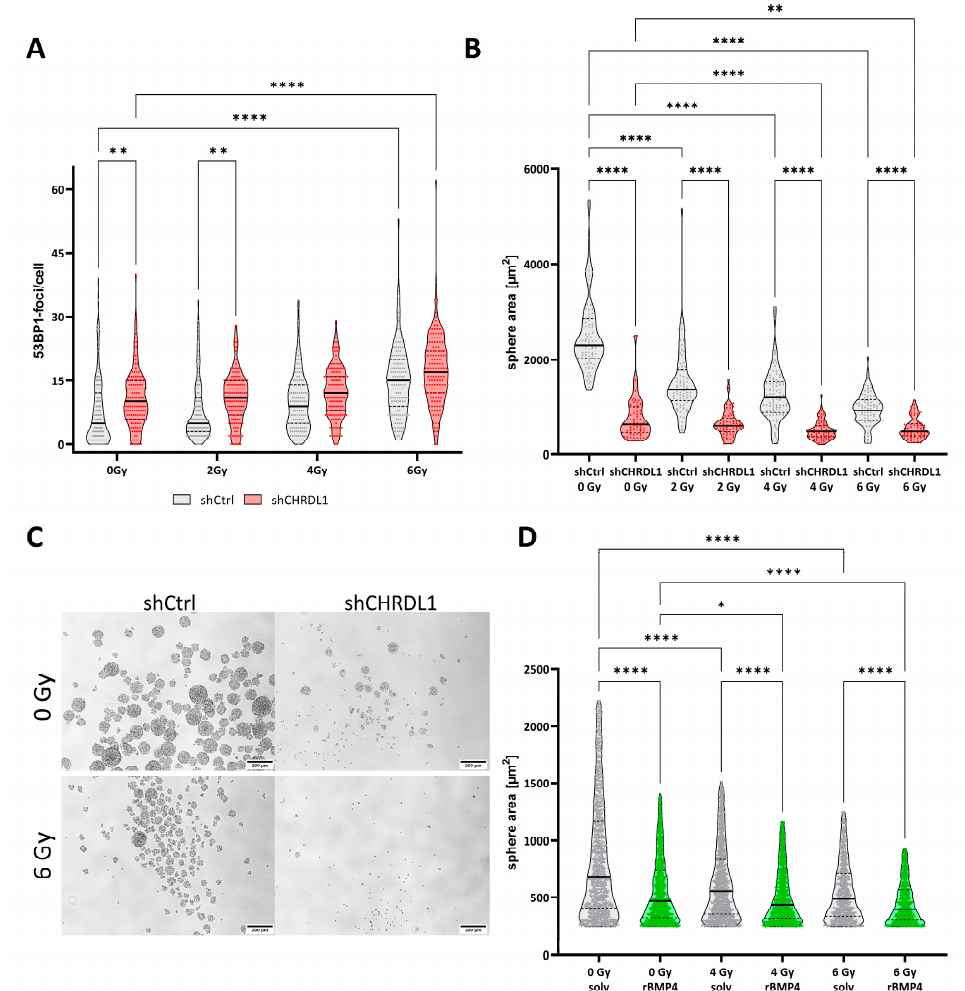
Figure 7. CHRDL1-depletion radiosensitizes GSCs. ( A ) 53BP1 foci assay 24 h after irradiation of NCH644 shCtrl or NCH644 shCHRDL1 GSCs with the indicated doses. ( B ) Sphere formation of NCH644 shCtrl or shCHRDL1 cells 7 days after seeding of single cells and irradiation as indicated. ( C )